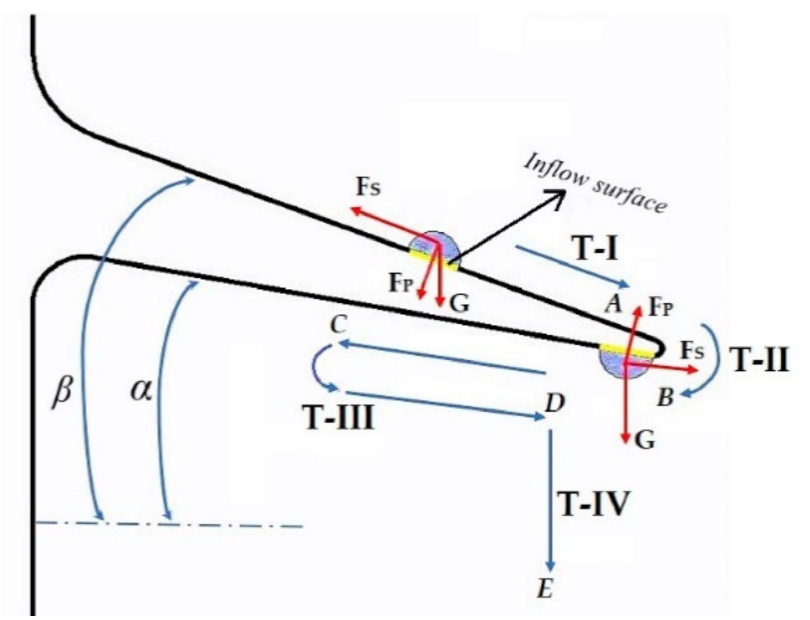
Figure 8. Typical motion trajectory of the surface water-drop during the rain test. It is noteworthy that not all surface water-drops had traces of these four stages. The movement characteristics of water-drops varied depending on the intensity of surface water-flow, the inclination angle of the shed, the surface hydrophobic state, the initial diameter of water-drops, and the purity of liquid, etc. Some water-drops may have dropped directly from the shed edge before reaching the lower surface of the insulator